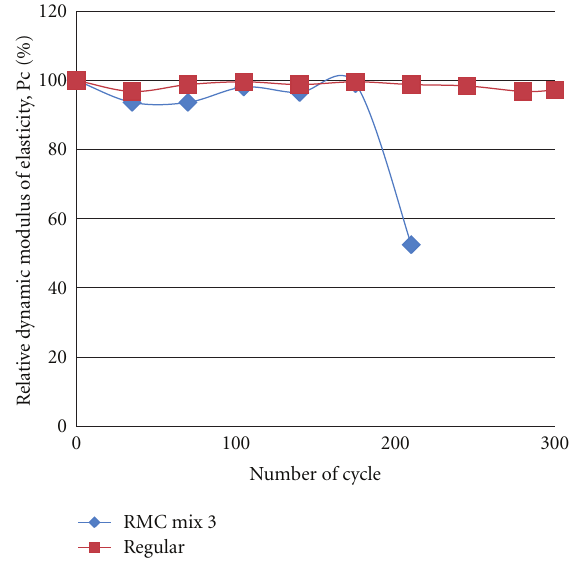
Figure 10: Average relative dynamic modulus of elasticity versus freeze-thaw cycles.